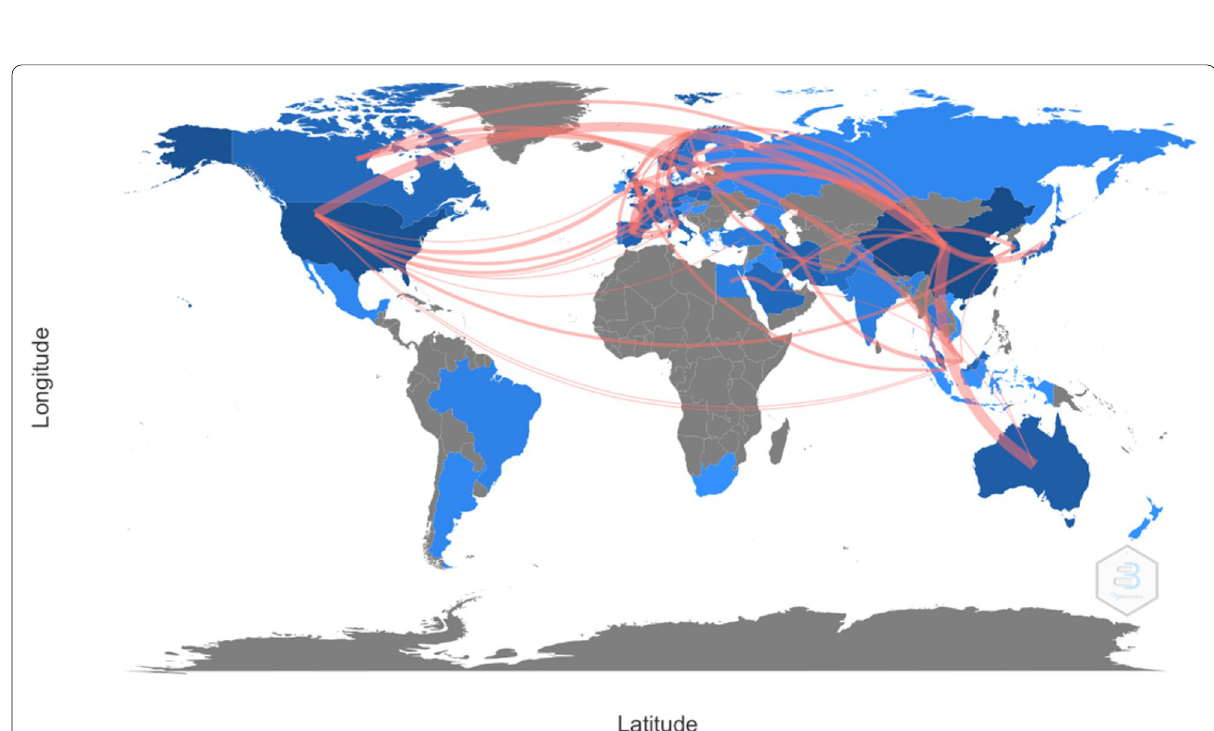
Fig. 36 Membrane, country collaboration